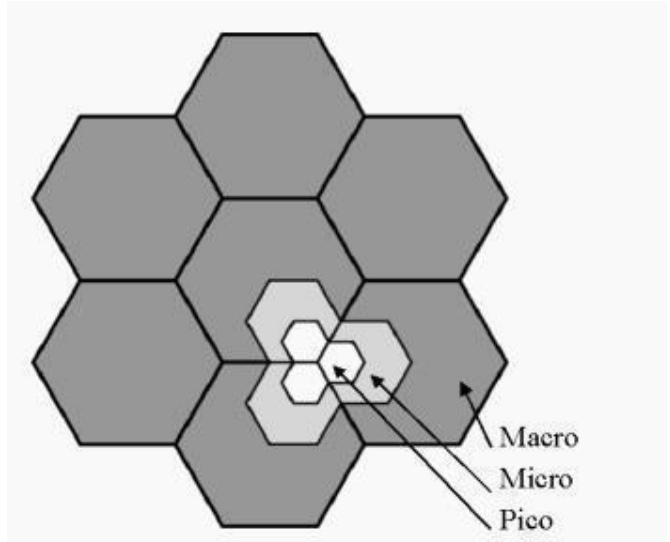
Fig. 3. Structure of cells after proposed cell splitting [Cell splitting- Mobile computing,